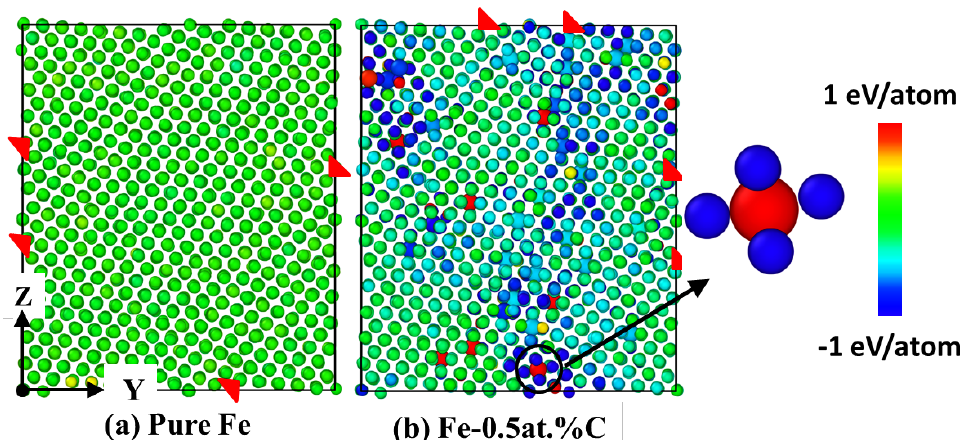
Figure 5. The atoms are colour coded as per the (cid:52) E values at 400 K for fcc phase with parallel TB. The location of TB is indicated by red triangles. ( a ) Pure Fe, ( b ) Fe-0.5 at. %C. The radius of C atoms has been increased artificially for better visibility. Y (cid:107) [ ¯110 ] and Z (cid:107) [ 001 ]